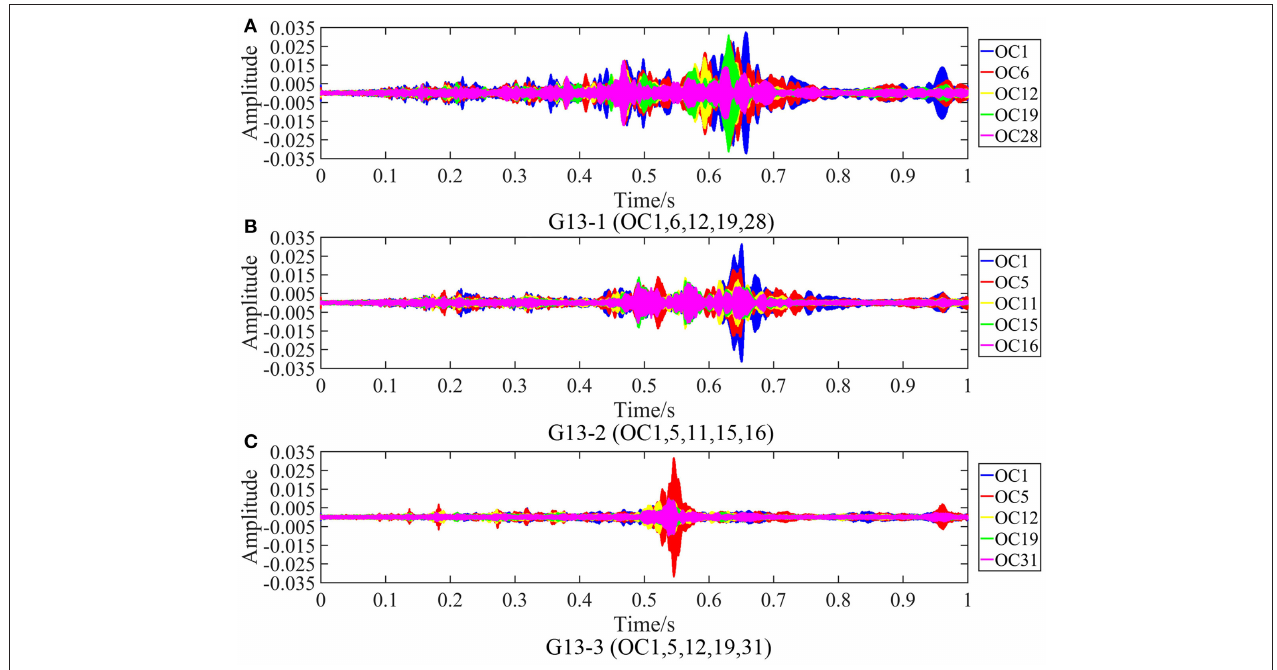
FIGURE 5 | Time domain of G13 after testing under different operating conditions. (A) Time domain of G13-1 under different operating conditions. (B) Time domain of G13-2 under different operating conditions. (C) Time domain of G13-3 under different operating conditions.